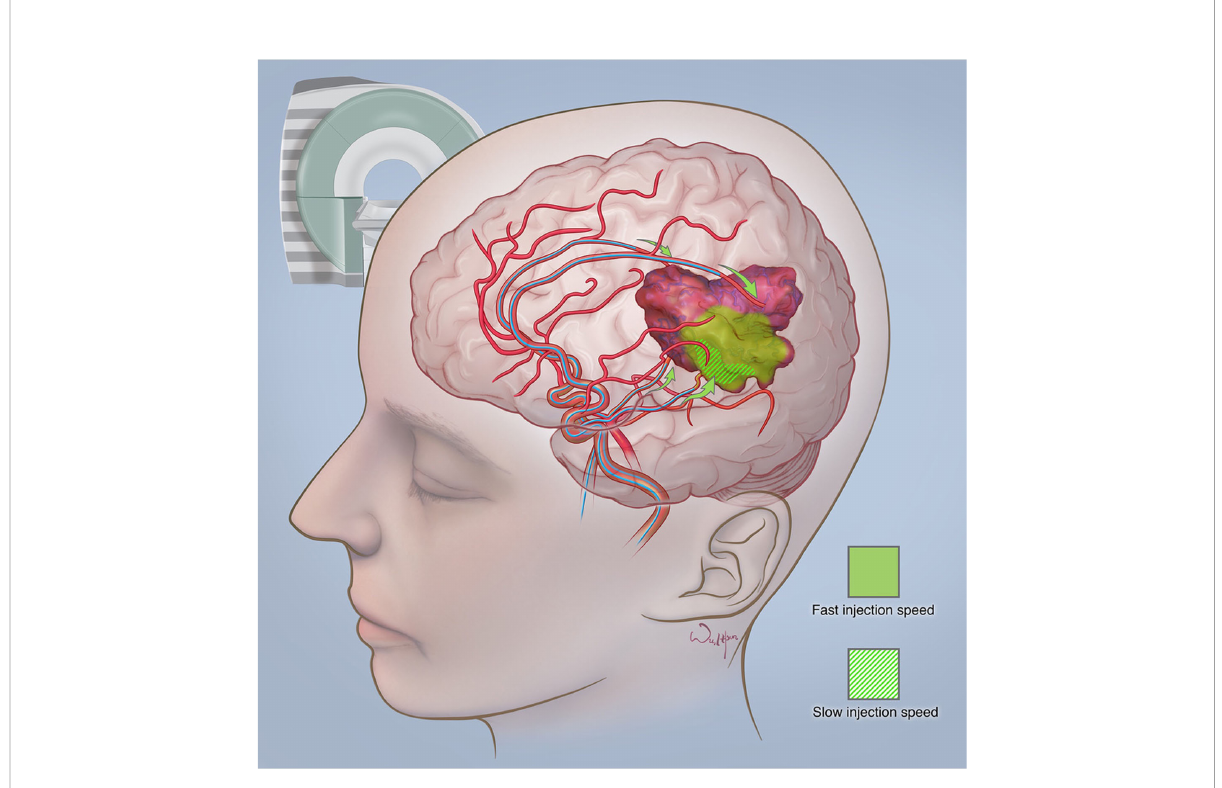
FIGURE 4 The difference between fast and slow infusion rates and their in fl uence on drug delivery. Courtesy of the Society of Image guided Neurointerventions